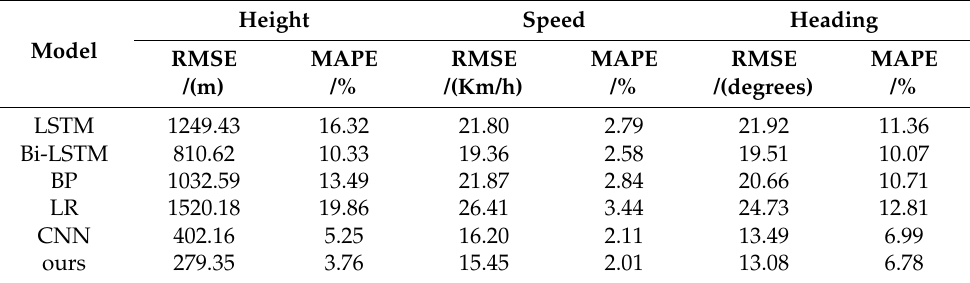
Table 3. Comparison of Prediction Indicators of Different Models.